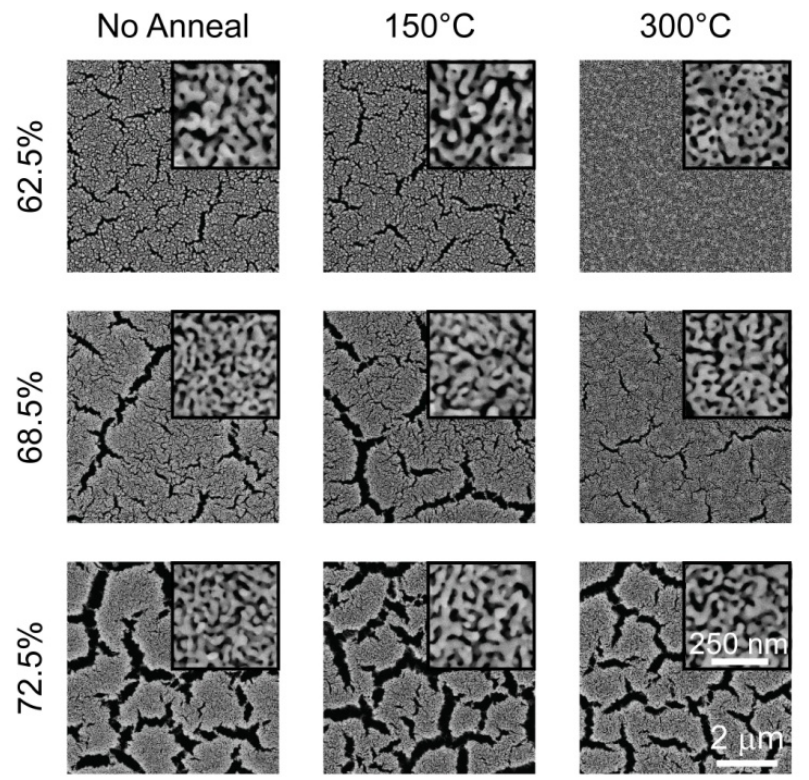
Figure 8. Micrographs of the np-Au films (with various initial Ag content) created by dealloying the thermally treated Au-Ag films. The larger images and the insets exemplify the typical crack formations and pore morphology, respectively. [Reproduced